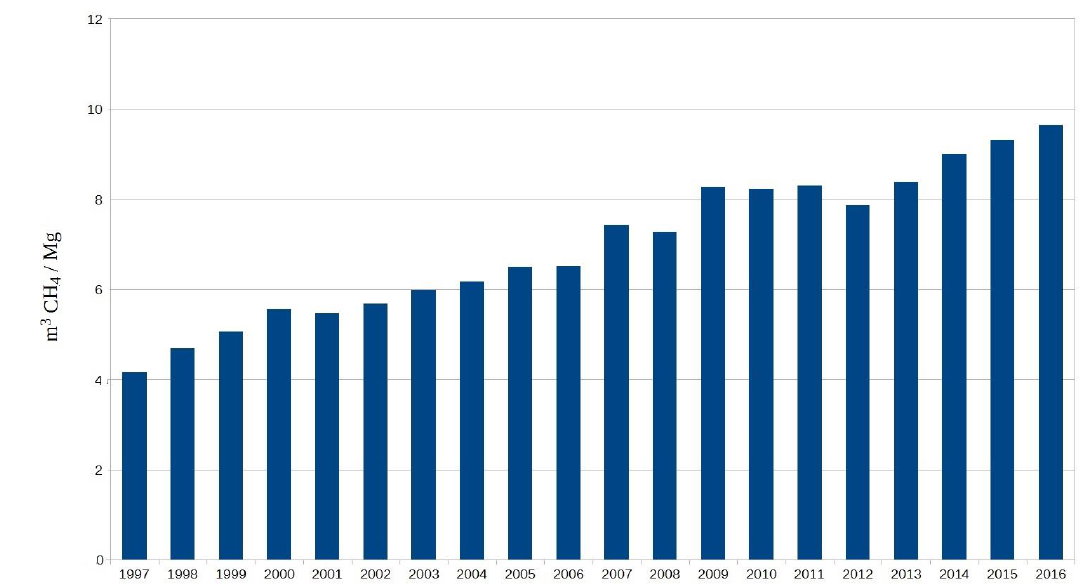
Fig. 11. Specific ventilation air methane (VAM) emission in the